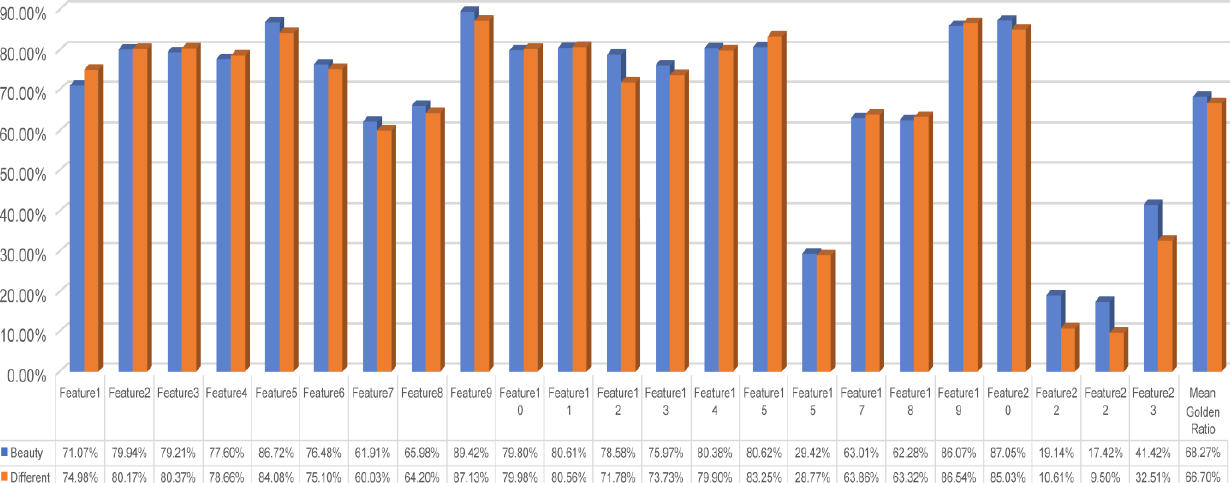
Figure 9. Features golden ratios.